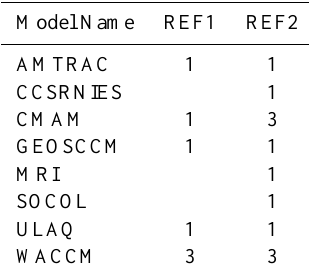
Table 2. CCMVal-1-1 models used in this study. REF1 and REF2 denote simulations for the 20th and 21st century, respectively. Num- bers indicate ensemble numbers of